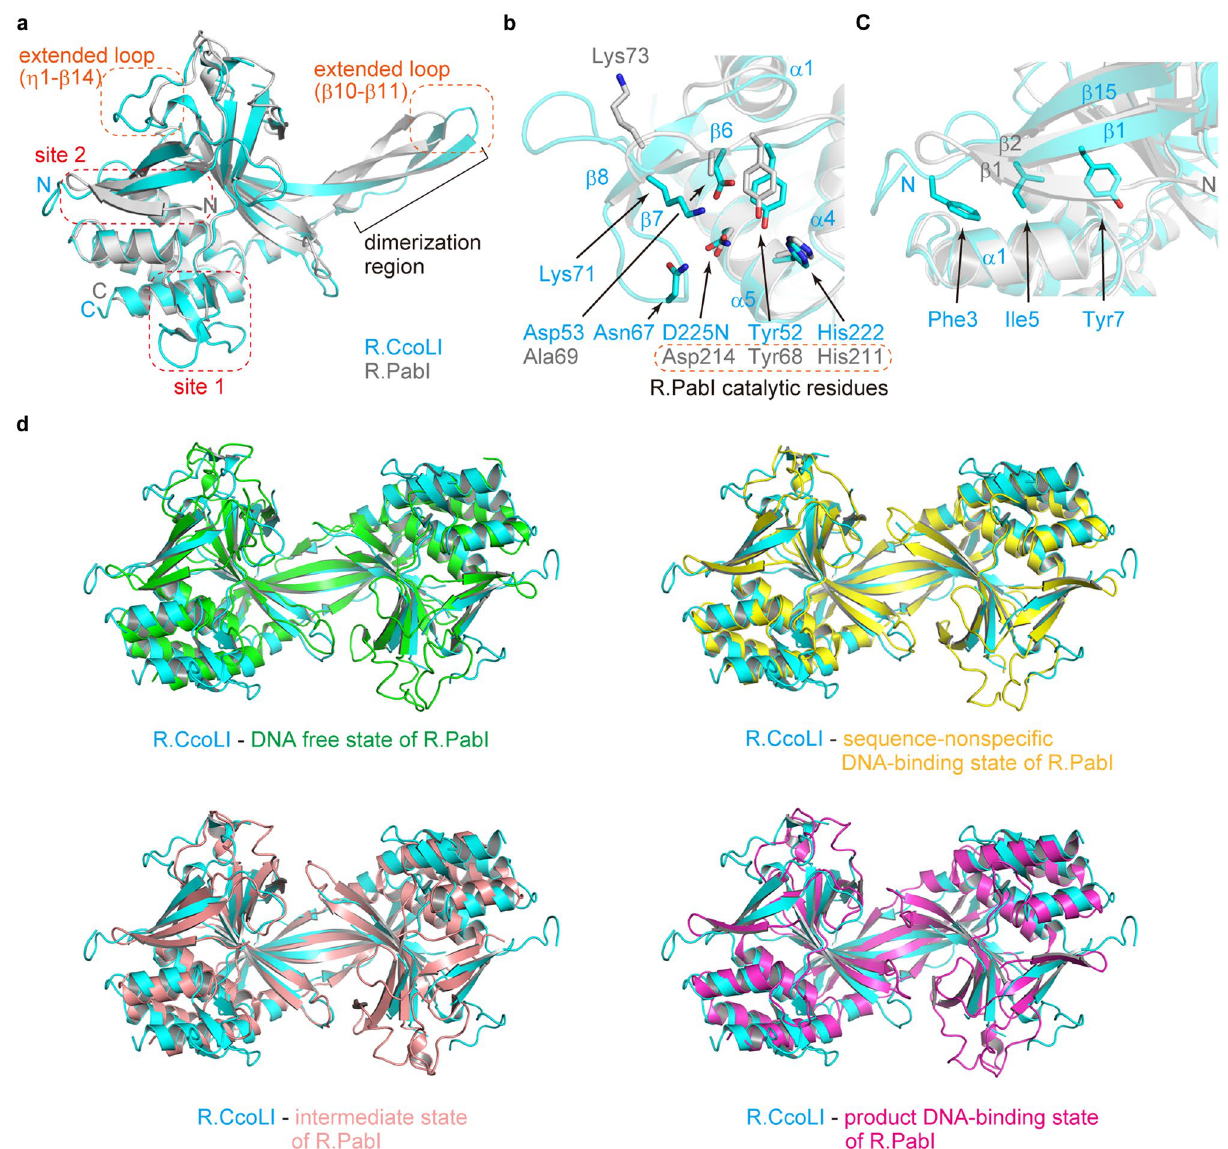
Figure 3. Comparison with R.PabI. ( a ) Characteristic structure of R.CcoLI. The structures of R.CcoLI protomer (chain A) and R.PabI protomer in the product DNA-binding state (PDB ID: 3WAZ, chain A) are superposed and are colored cyan and gray, respectively. Characteristic local structures in R.CcoLI that are not observed in R.PabI are indicated by red dotted squares (sites 1 and 2). The extended loops of R.CcoLI are indicated by orange dotted squares. ( b ) Structure of the insertion residues of R.CcoLI (site 1 in (A)). Residue numbers and secondary structures of R.CcoLI are labeled cyan. Residue numbers of R.PabI are labeled gray. ( c ) Structure of the N-terminal region of R.CcoLI (site 2 in (A)). Secondary structures of R.CcoLI and R.PabI are labeled cyan and gray, respectively. ( d ) Superposition of the dimeric structure of R.CcoLI (cyan) and those of R.PabI in the DNA-free state (PDB ID: 2DVY, green), the sequence-nonspecific DNA-binding state (5IFF, yellow), the intermediate state (PDB ID: 6L2O, salmon pink) and the product DNA-binding state (3WAZ,